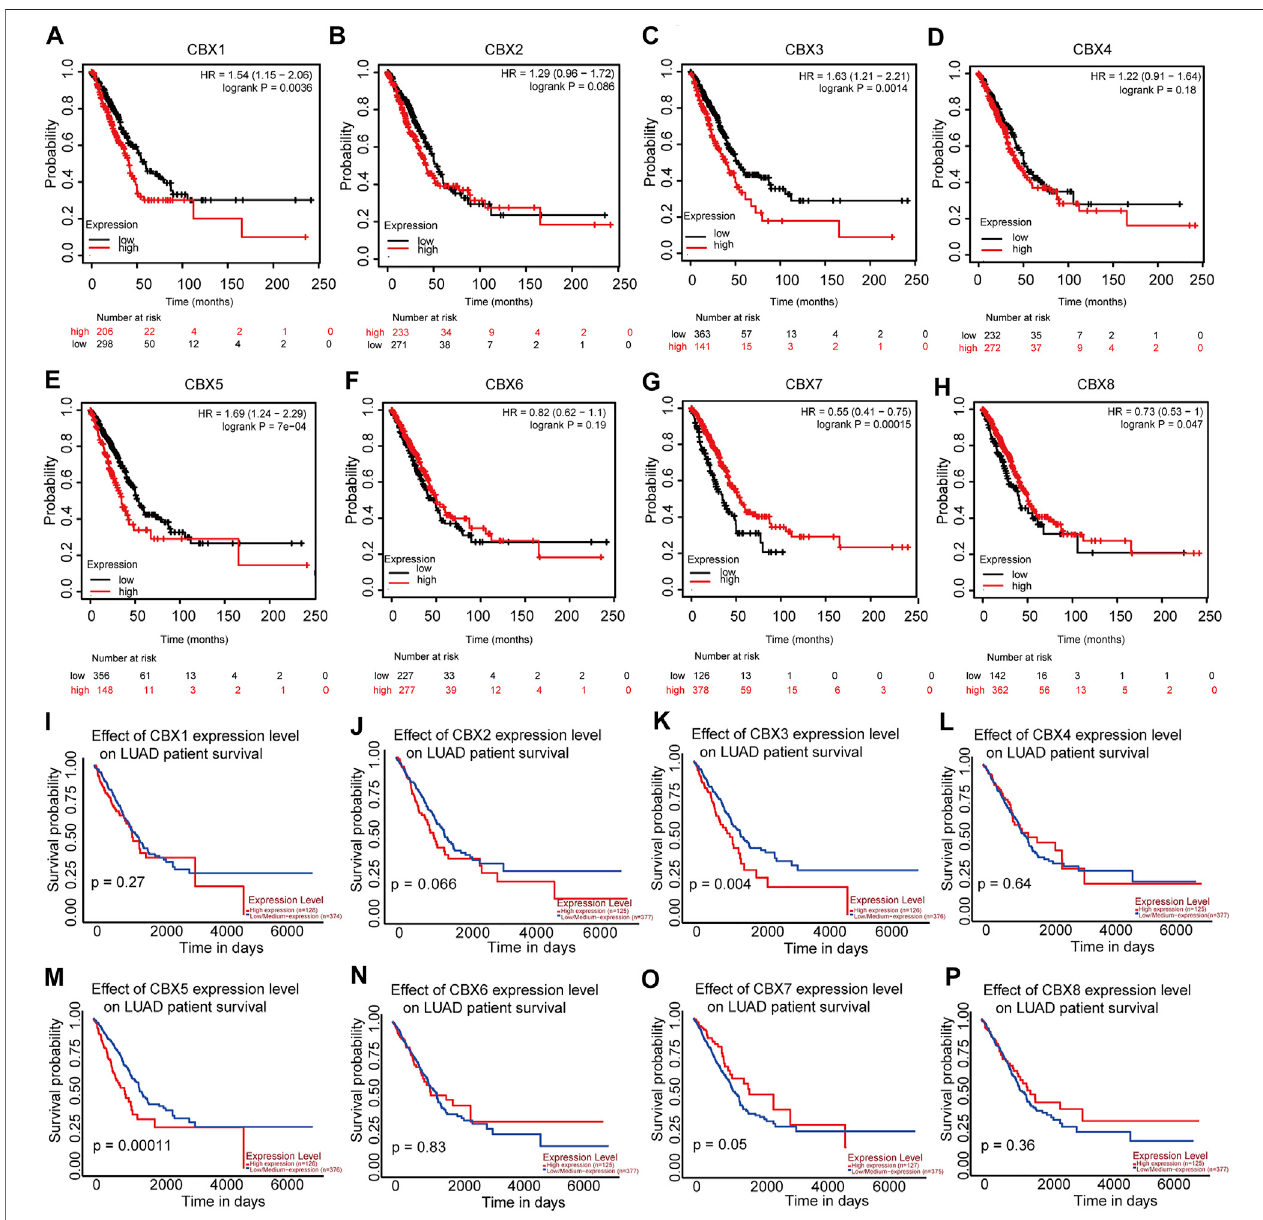
FIGURE4| CBX1/3/5/7/8correlationswithLUADprognosis. (A – H) CorrelationsbetweenCBX1/3/5/7/8andoverallsurvivalstatusinpatientswithLUAD(KM)and (I – P) in patients with LUAD (UALCAN).